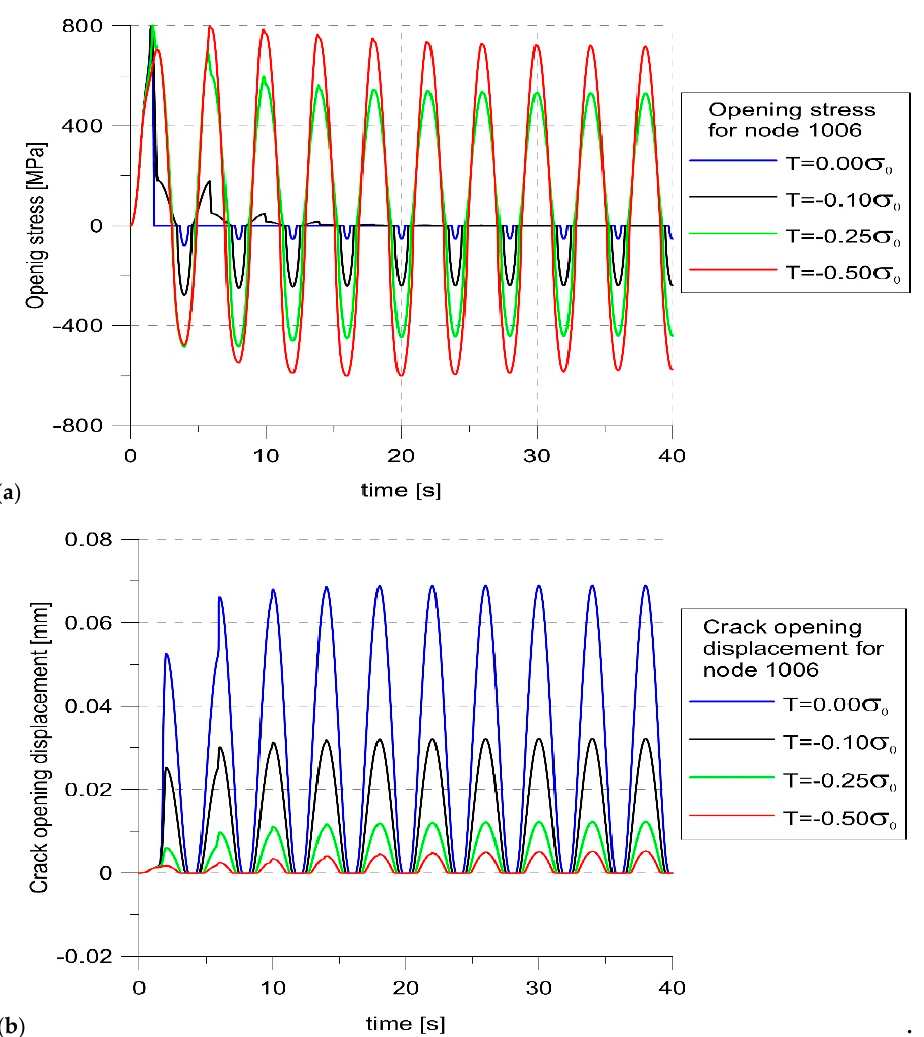
Figure 9. Changes in the opening stress ( a ) and COD ( b ) with load for node 1006. The constraints not only affected the level of the opening stress and the size of the opening. As can be seen in Figure 10, the highest crack growth rate was obtained for T = 0. The lower the constraint level, the shorter crack increase was obtained. To determine the moment of crack opening at each load cycle, the values of the opening stress for node 1006 were analyzed. If it changed from negative to positive, an opening occurred. On this basis, the moments of opening and closing of the crack at different levels of constraints were determined and marked with dots on the load diagrams (Figure 11). Comparing the values of SIF at the moment of opening, it was clear that these values were strongly influenced by the constraint level. For the highest level of constraint, the crack opened earlier.